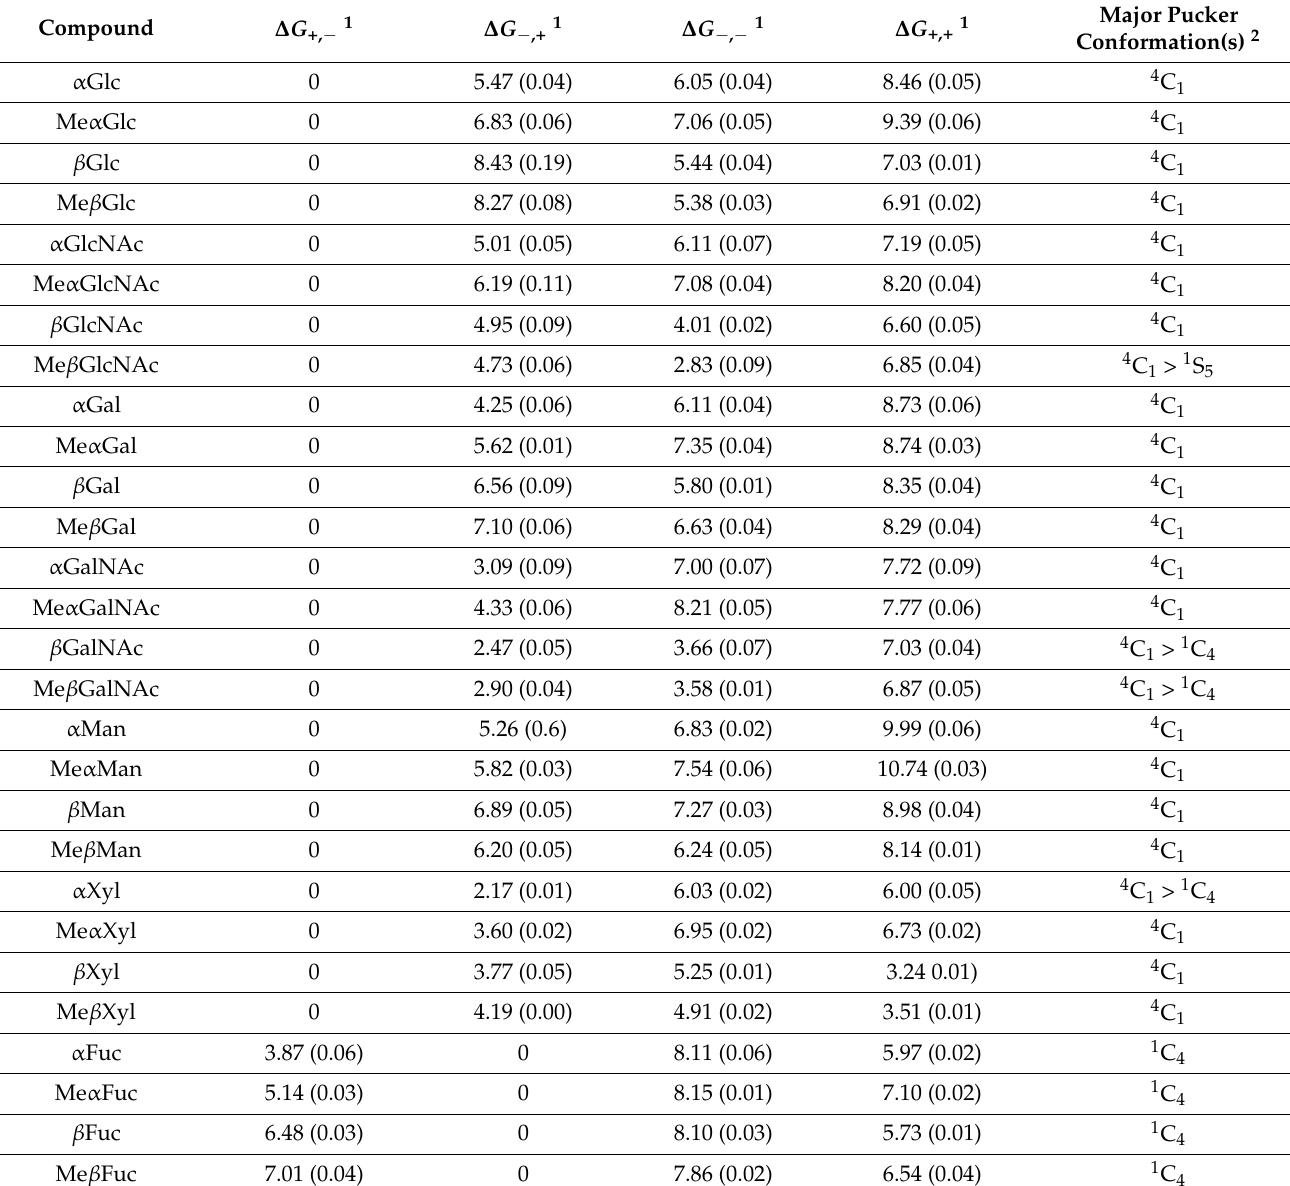
Table 2. Minimum ∆ G ( α 1 , α 2 ) values in each of the four quadrants of the ( α 1 , α 2 ) reaction coordinate, and the corresponding major ring puckering